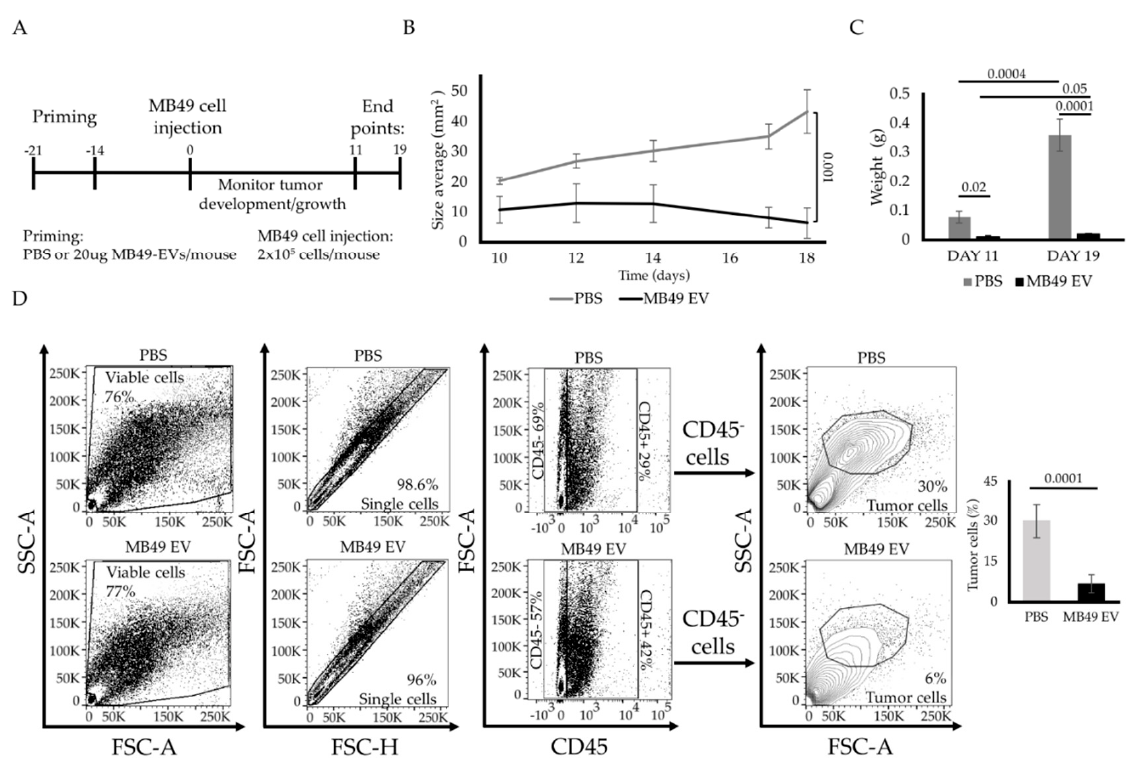
Figure 2. MB49 EV priming prevents MB49 tumor establishment in a syngeneic mouse model. ( A ) Diagram of in vivo experimental design timeline. ( B ) Subcutaneous MB49 tumor growth curve (mm 2 ). ( C ) Bar graphs of the averaged harvested tissue weight at day 11 (left panel) and day 19 (right panel). ( D ) Flow cytometry gating strategy and percentage of tumor cells identified by cell size and complexity in harvested tissues at day 19. The n number is 7 on each group. Error bars show standard error. Statistical significance was calculated by independent Student t -test and two-way ANOVA with Tukey’s multiple comparisons test.